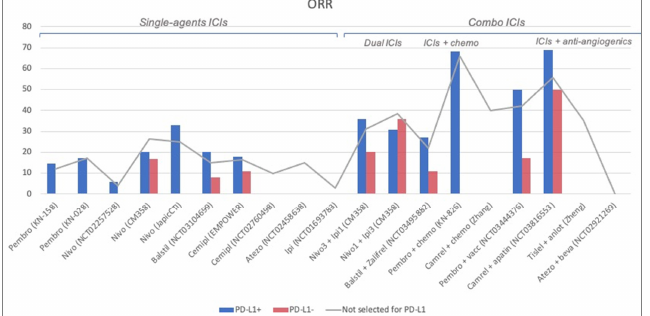
Figure 2. Overall response rate (ORR) of the included studies. ORR of the studies for patients not selected for Programmed Death Ligand 1 (PD-L1) status ( gray line ), PD-L1-positive patients ( blue bar ), and PD-L1-negative patients ( red bar ) are reported. In patients not selected for PD-L1, ORR ranged from 0% to 26.3% with single-agent ICIs, reaching 38.4% with dual ICIs association, 65.9% with the combination of ICIs and chemotherapy, 55.6% with ICIs plus tyrosine-kinase inhibitors (TKIs). In PD-L1-positive patients, ORR ranged from 5.9% to 33% with single-agent ICIs, from 27% to 36% with dual ICIs, reaching 68.1% and 69% when ICIs were combined with chemotherapy and TKIs, respectively. In PD-L1-negative women, ORR was 0–16.7% to single-agent ICIs, 11–35.8% to double ICIs, and reached 50% after ICIs + TKIs. A total of 8 studies reported DCR, ranging from 30.6% to 94.1%. A total of 13 studies reported mPFS that ranged from 2 to 10.4 months. mOS was reported by 14 studies and ranged from 8 months to NR (Figure 3).